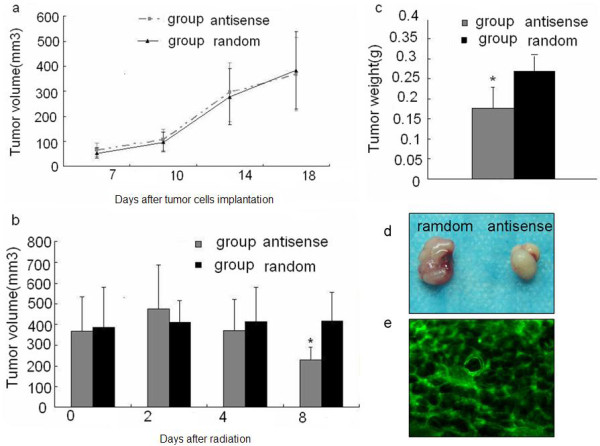
Effect of HSP70 antisense oligos on radiotherapy of laryngeal carcinoma xenografts. (a) shows the tumor growth curve before radiation, no difference between the 2 groups were found, the tumor volum were for antisense and random group, respectively (P > 0.05, 368 ± 129 mm3vs 384 ± 179 mm3). (b)There was significant difference in tumor volumes after 5Gy radiation (P < 0.05, 229 ± 28 mm3 vs 417 ± 103 mm3) (c) Tumor weights also showed significant difference after 5Gy radiation (P < 0.05, 0.18 ± 0.04 g vs 0.27 ± 0.05 g). (d) showed the representative sample of group antisense and group random after 5Gy radiation (e) showed the infection efficiency of intratumoral injection.:100×. n = 8 per group,* < 0.05.